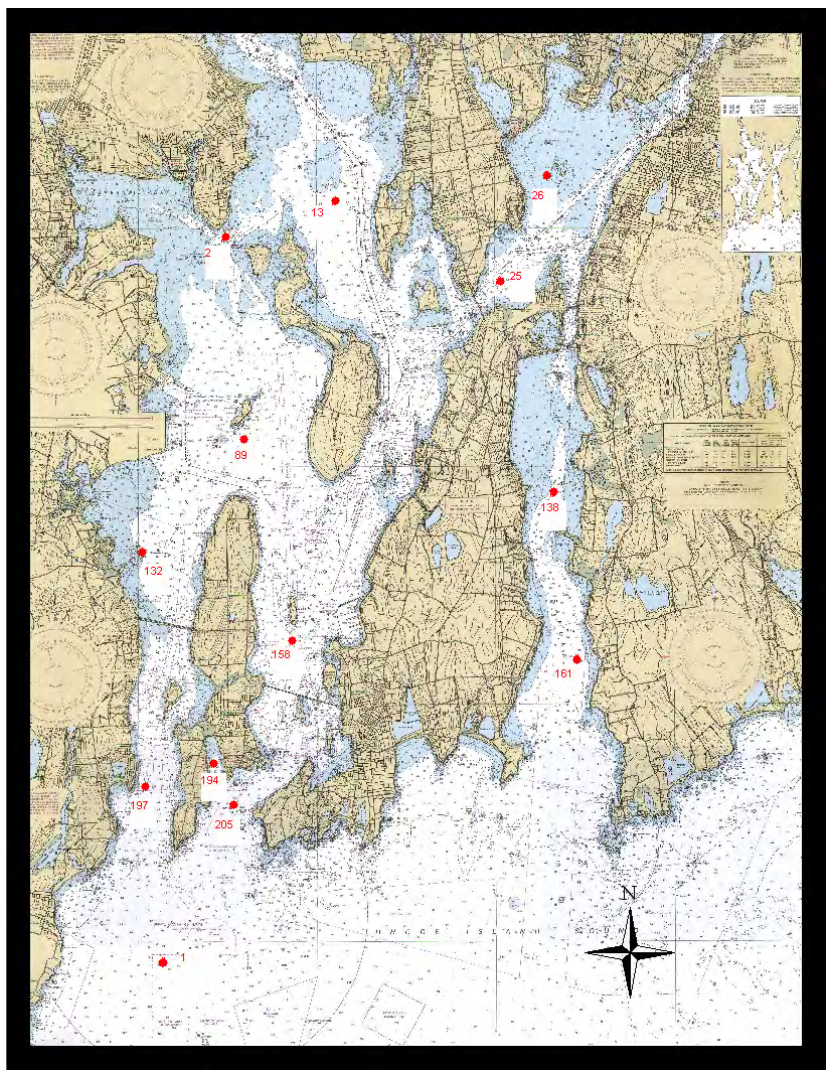
Figure 28. Map of Rhode Island Coastal Trawl Survey Monthly Segment fixed tow